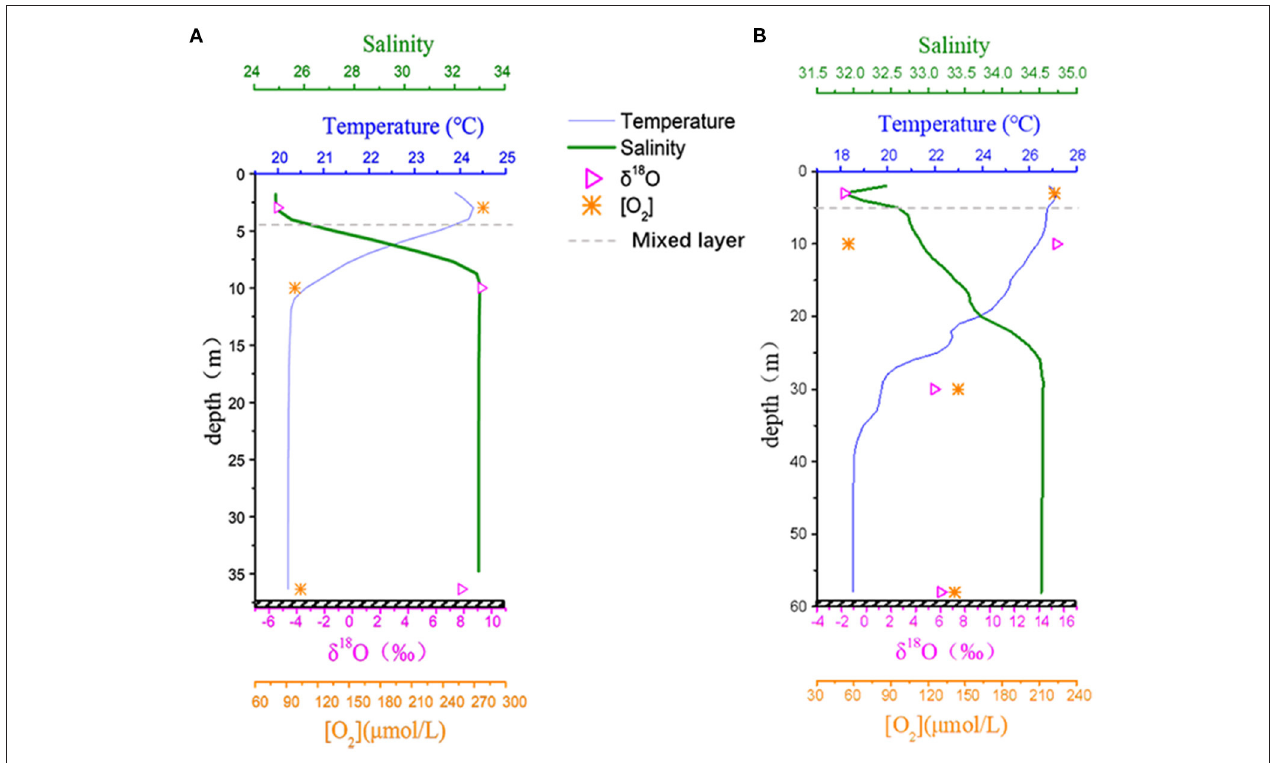
FIGURE 5 | Vertical profile of salinity, temperature ( ◦ C), and [O 2 ] ( µ mol/L) calculated using δ O 2 /Ar, and δ 18 O ( ‰ ) for (A) station D3 and (B) station E2. The gray dashed lines indicate the depth of the upper mixed